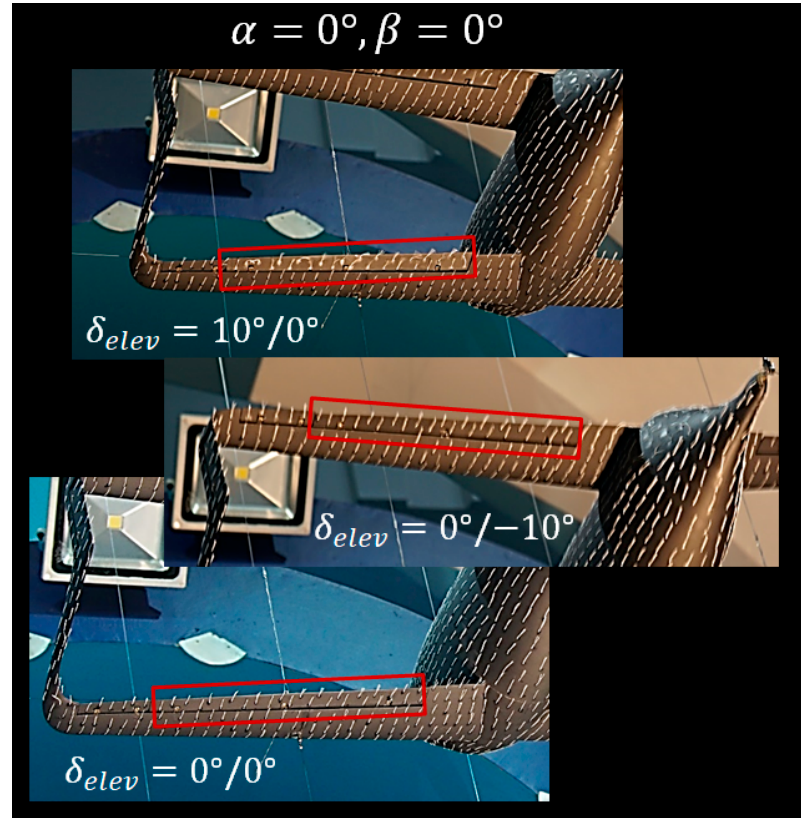
Figure 15 . Tuft patterns over the fore right elevator at various deflection angles . Figure 15. Tuft patterns over the fore right elevator at various deflection